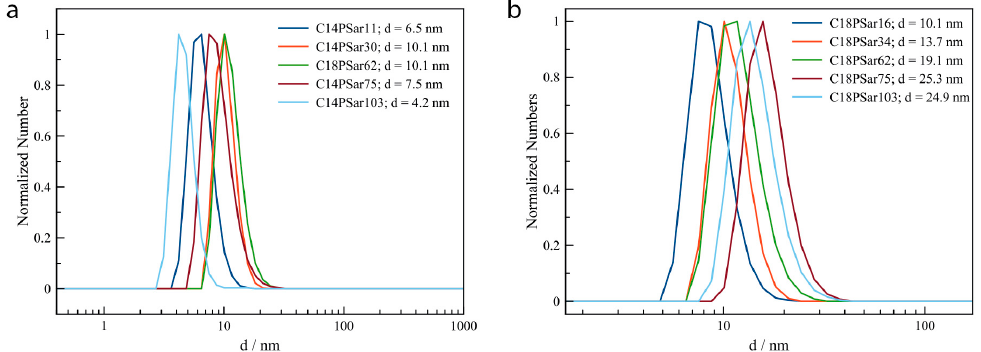
Figure A3. Number weighted diameter distribution of lipopolypeptoid determined by dynamic light scattering (DLS). ( a ) Series of tetradecyl amine (C 14 ) based lipopolypeptoids; and ( b ) Series of stearyl amine (C 18 ) based lipopolypeptoids.